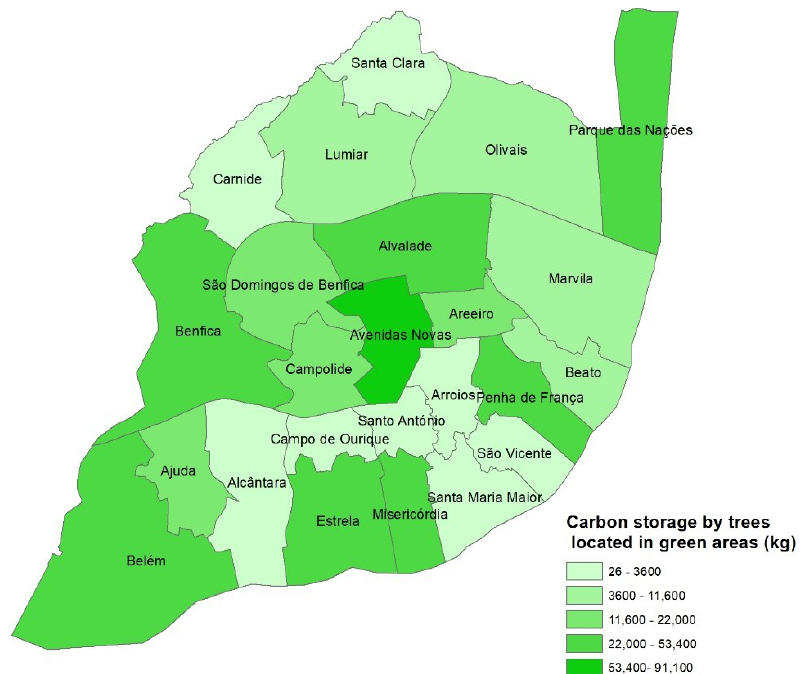
Figure 10. Carbon storage by trees located in green areas for each parish of the city of Lisbon.